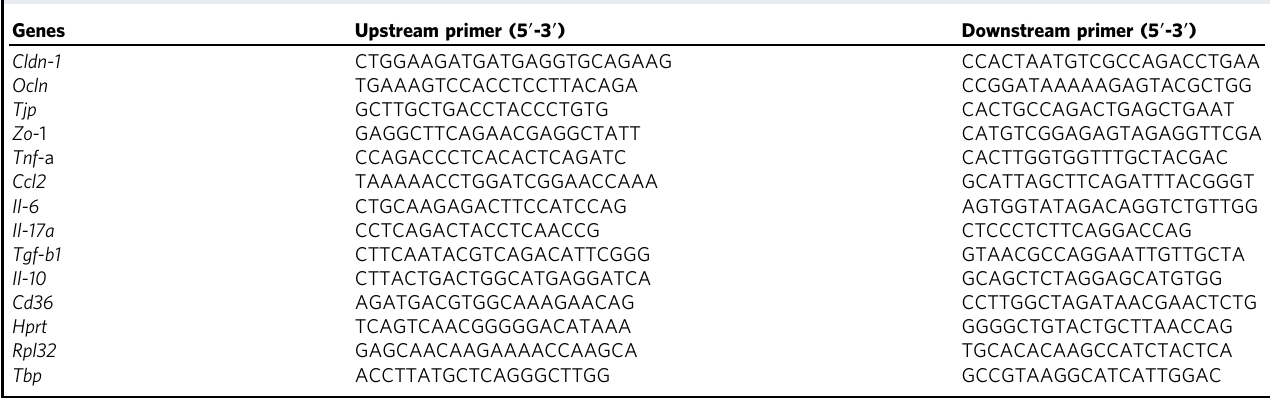
Table 1 Primers for quantitative